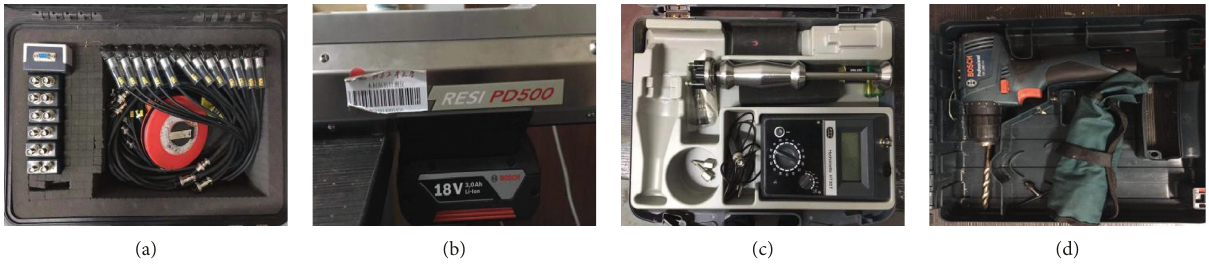
Figure 4: Specimen and test equipment. (a) Fakopp. (b) IML-RESI PD500. (c) GANN-HT85T. (d) BOSCH.